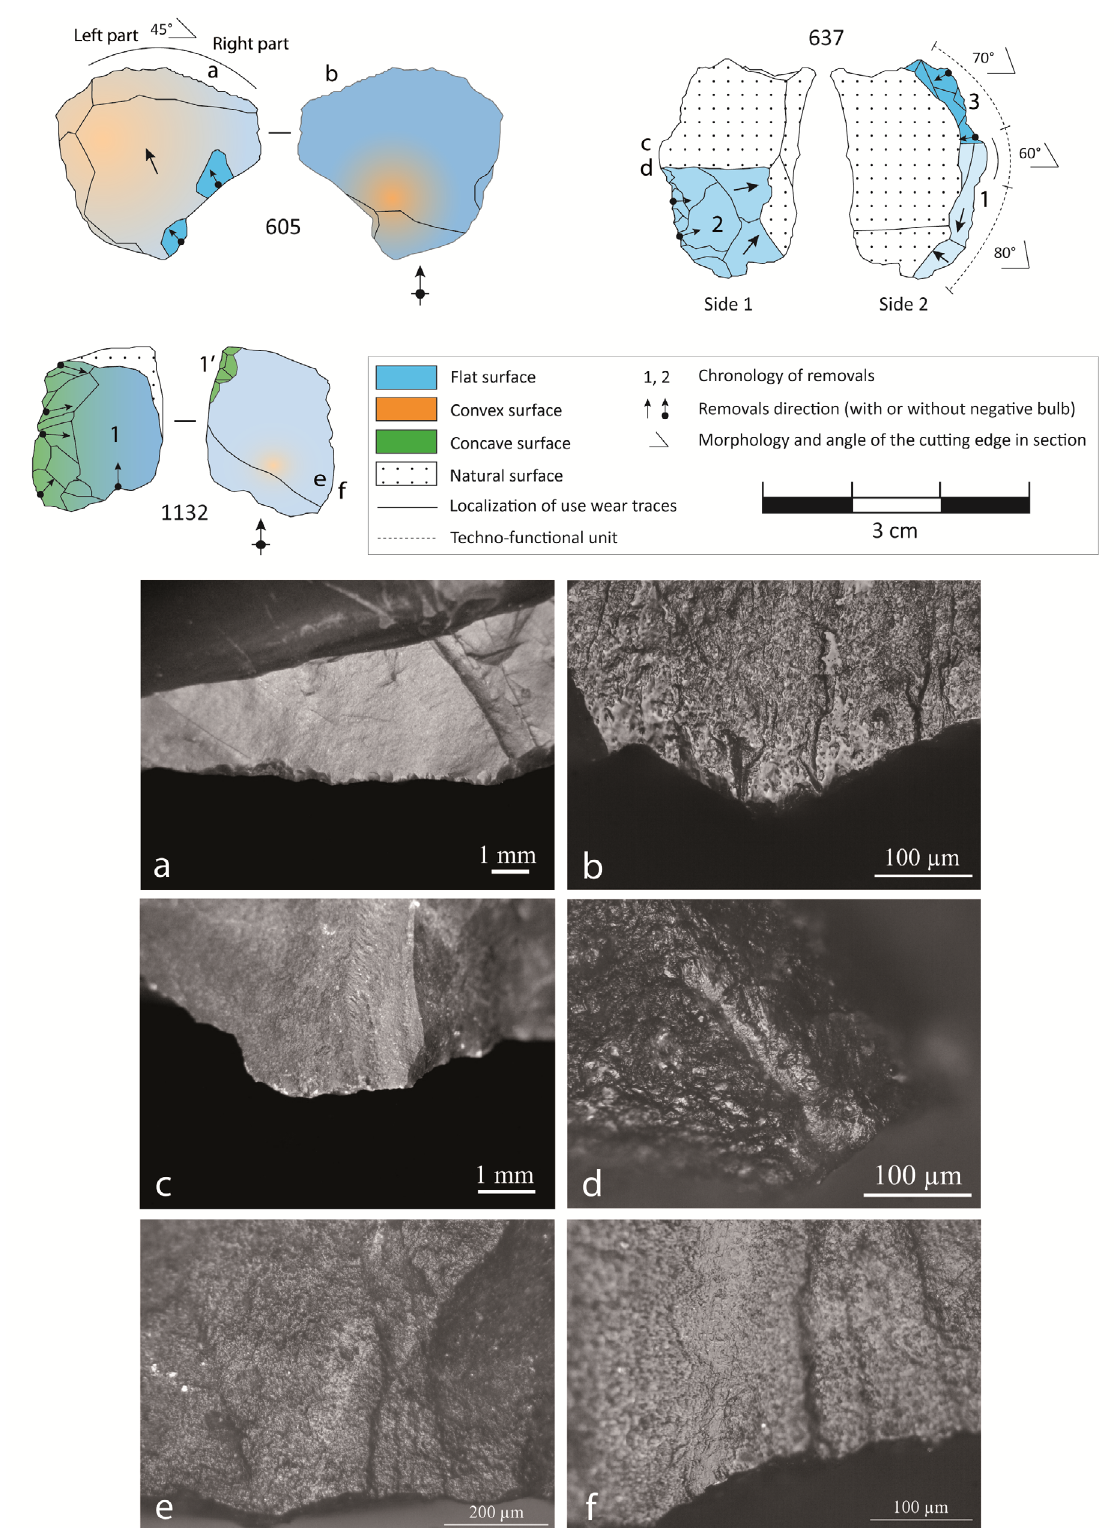
Figure 6: Diacritical sketches of lithics with functional and technological traces and photos of traces. a. and b. circular and elongated small scars opposite to a smooth domed polish on the cutting edge of flake 605 (used to process plant remains in a transversal unidirectional motion); c. and d. small irregular scars opposite to a rough to smooth polish on a slightly rounded arris with long striations perpendicular to the edge of flake 637 (related to technological traces or utilized on a semi hard material in a transversal bidirectional motion); e. and f. large band of polish in the center of a crescent-shaped crack and numerous organized striations on the ventral surface opposite the retouch scars of flake 1132 (technological